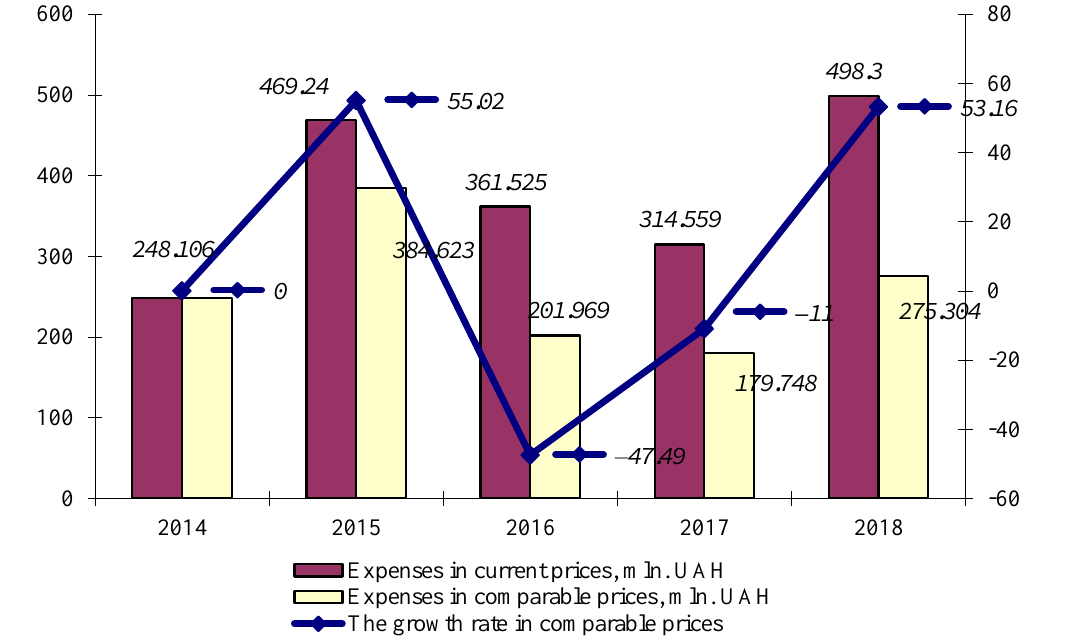
Fig. 3. The dynamics of government spending on the purchase of anti-TB D in the national currency for 2014–2018